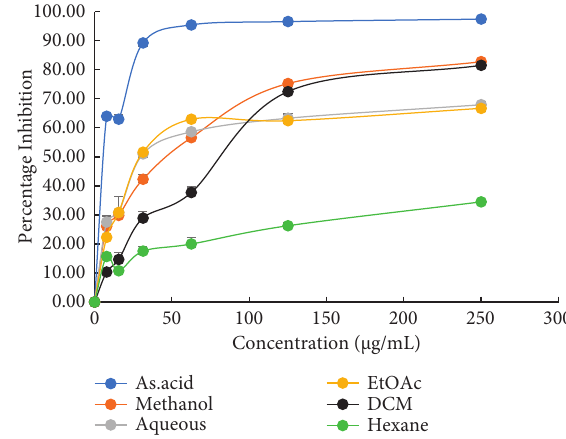
50 ) of different